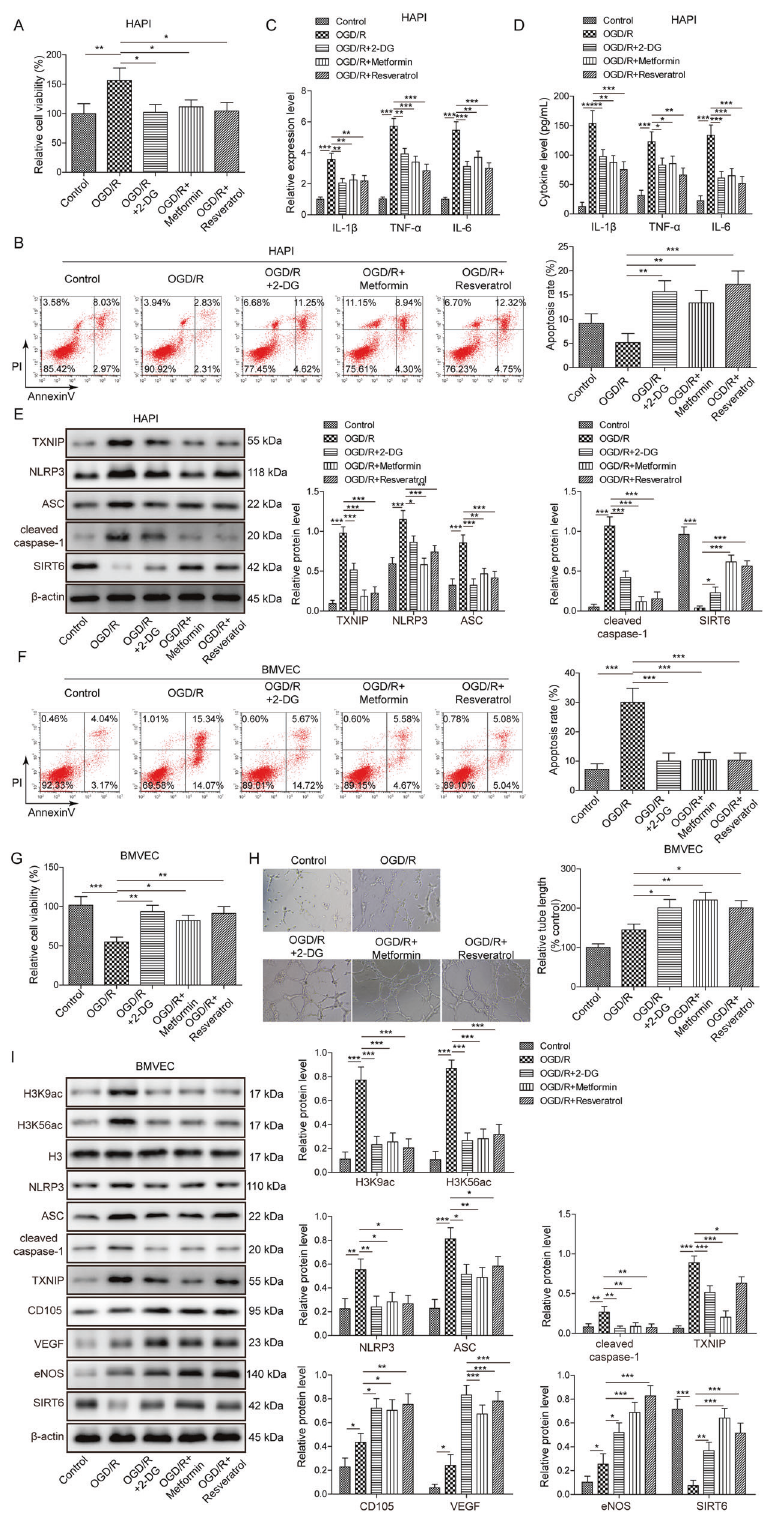
Fig. 3 ER mimetics protect against OGD/R-induced microglial activation in HAPI cells, and potentiate OGD/R-induced angiogenesis in BMVECs. HAPI cells or BMVECs were pre-treated with ER mimetics, followed by OGD (2 h)/R (24 h) treatment. A The cell viability of HAPI cells was monitored by MTT assays. B The cell apoptosis of HAPI cells was monitored by Annexin-V/PI staining. C , D The mRNA or secretion levels of cytokines in HAPI cells were determined by qRT-PCR and ELISA assay, respectively. E The protein levels of target proteins in HAPI cells were determined by Western blotting. F The cell apoptosis of BMVECs was monitored by Annexin-V/PI staining. G The cell viability of BMVECs was monitored by MTT assays. H The angiogenesis of BMVECs was evaluated by tube formation assay. I The protein levels of target proteins in BMVECs were determined by Western blotting. β -actin acted as a loading control for Western blotting. * p < 0.05, ** p < 0.01, and *** p < 0.001.